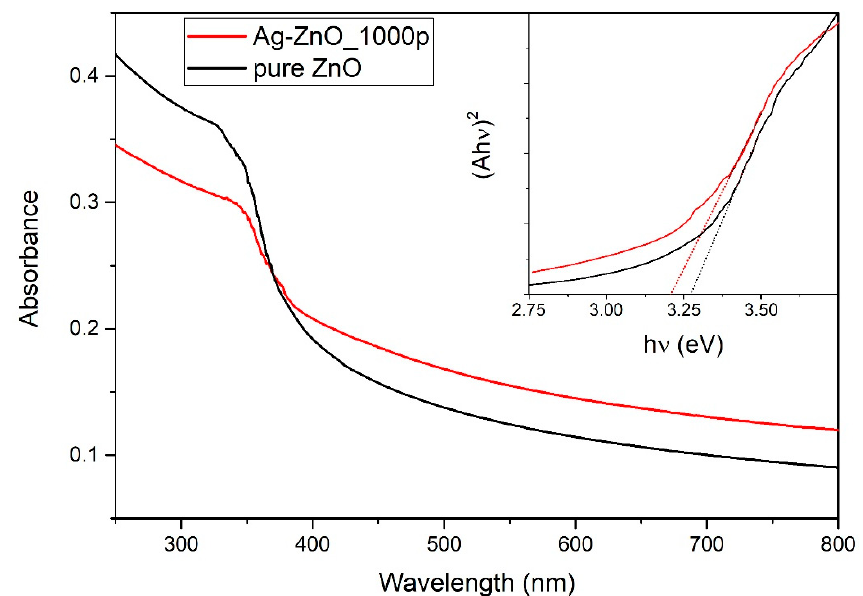
Figure 10. Photoabsorbance spectrum of colloidal solutions of pure ZnO NPs and Ag-doped ZnO NPs synthesized with 1000 pulses in PLD.